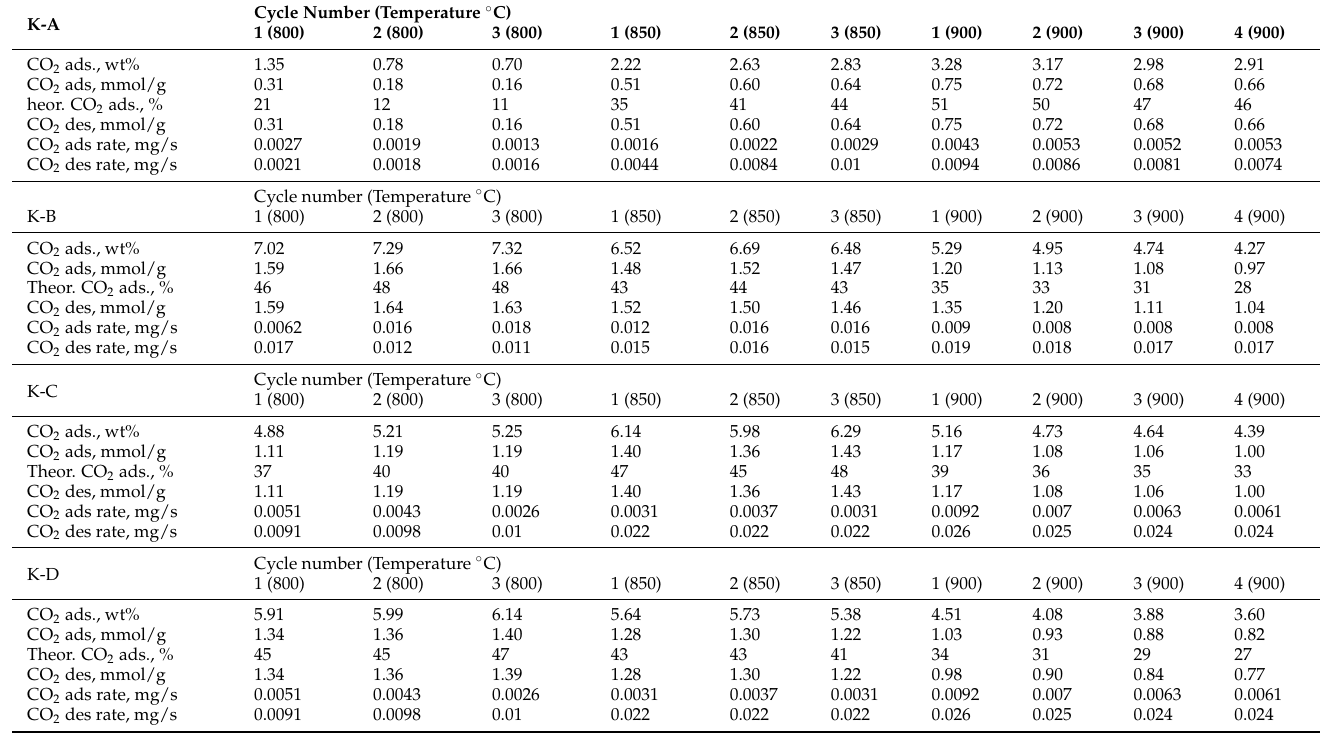
Table 2. Performance of stannates synthesised